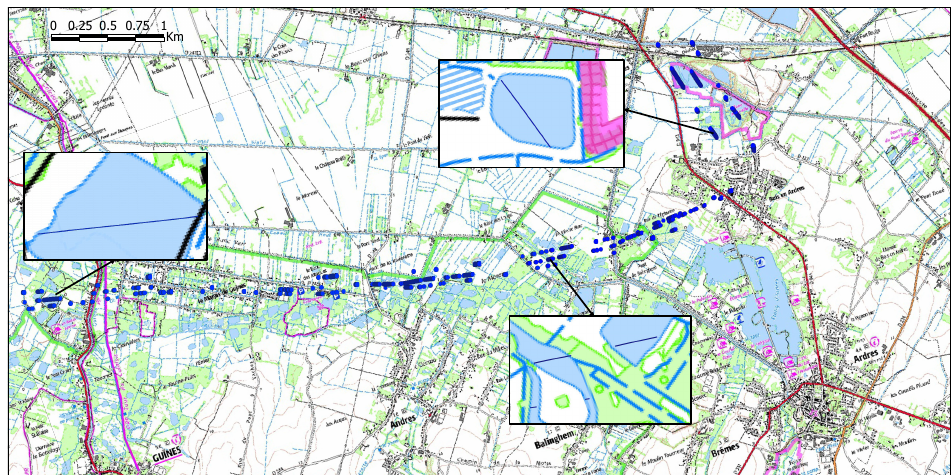
Figure 15. The detected water body surfaces using our proposed radar technique for the area between Guînes and Ardres. The specular points of reflection, represented by a blue coloring, are superimposed on IGN maps.